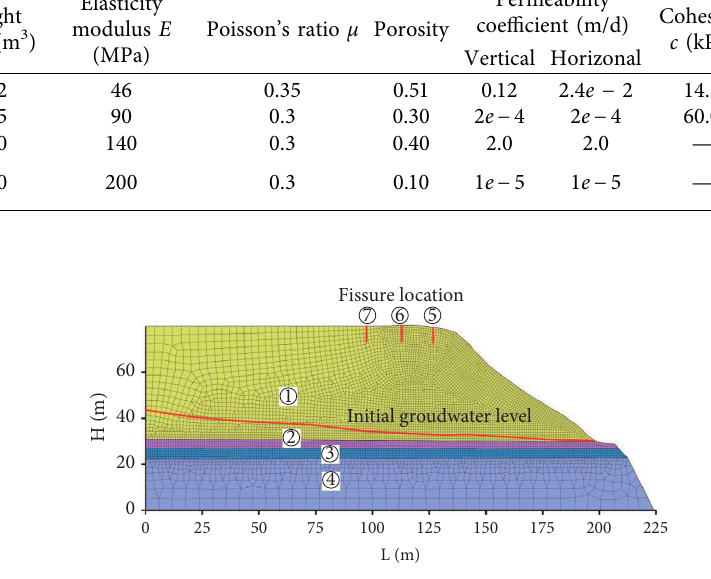
Figure 10: The calculation model ( ① loess; ② silty clay; ③ sand and gravel; ④ sandy mudstone interbedding; and ⑤ , ⑥ , and ⑦ the distance between the fracture location and the edge of the pier is 5m, 15m, and 33m).